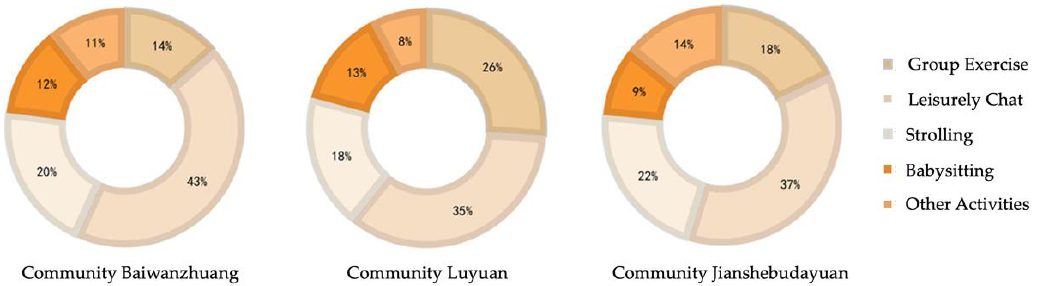
Figure 3. Types and proportions of social interaction of elderly women. Data from observation and questionnaires show the preferred time of social